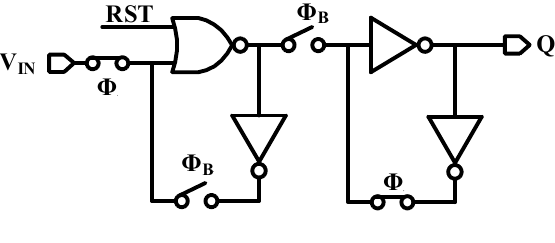
Figure 7. Quasi-static D-Flip Flop.